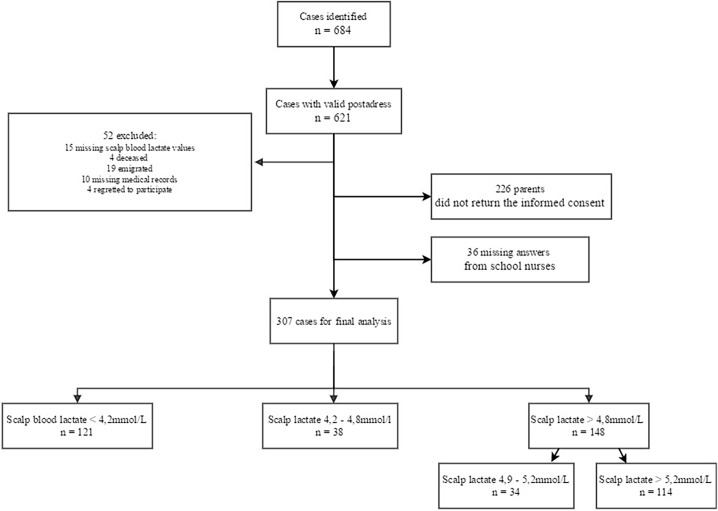
Flow chart demonstrating exclusions and group division based on the levels of scalp blood lactate.